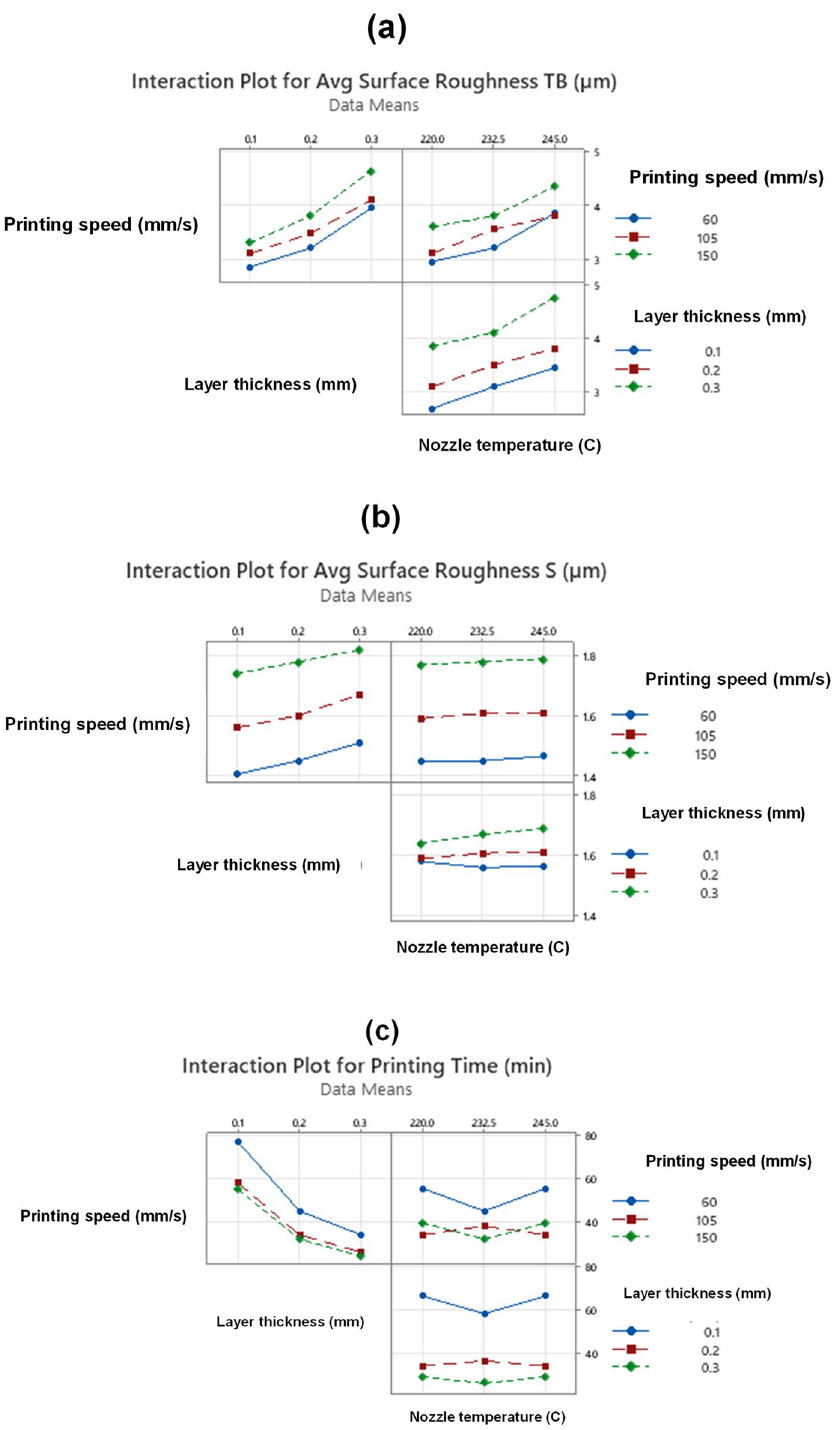
Figure 4. Interaction plot between FFF parameters versus part